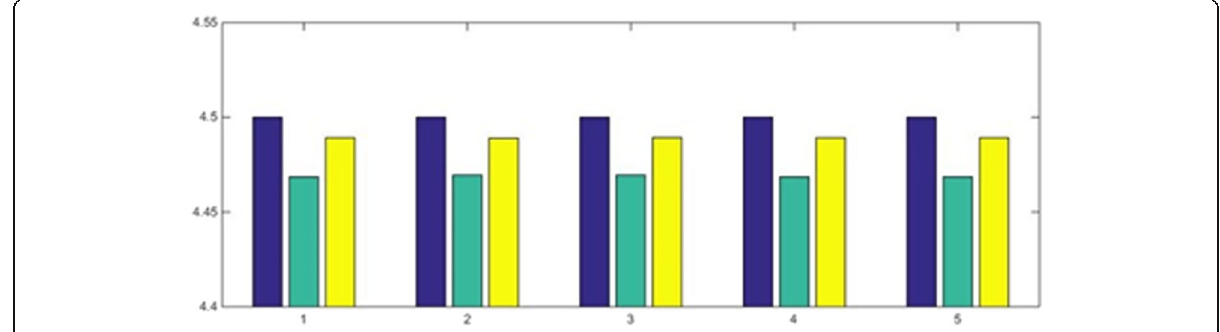
Fig. 9 Comparison of measured value (unit mm)